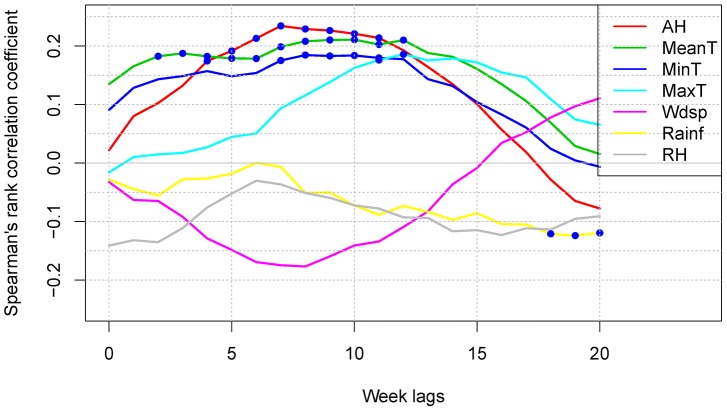
Time-lagged cross-correlation of dengue incidence and each weather variable (0 to 20-weeks lag).Significant correlation coefficients with p-value<0.05 are in solid circles.